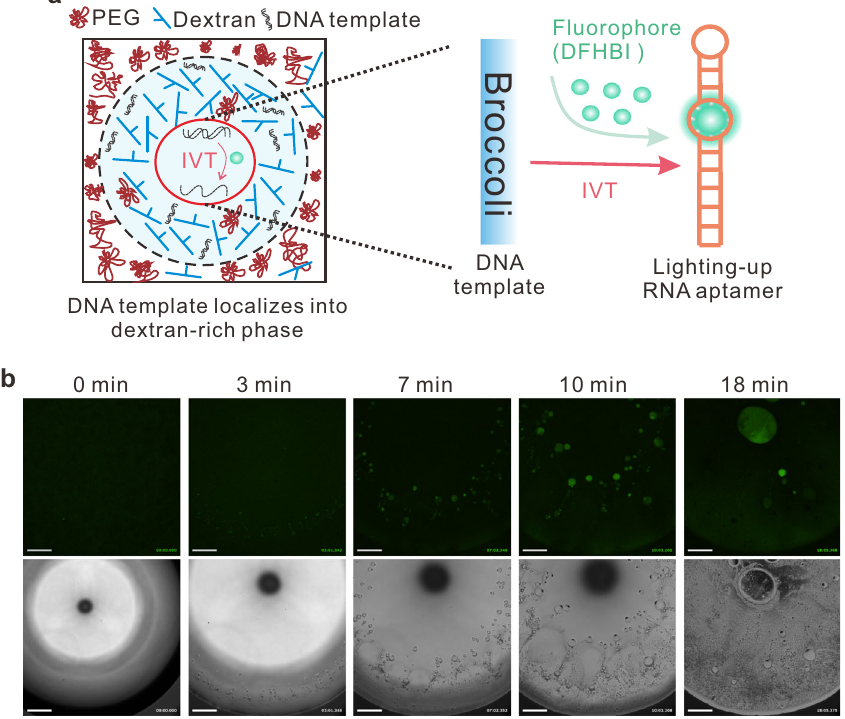
Fig. 4 In vitro transcription of functional RNA aptamers inside the evaporating sessile droplets. a The fl ow of genetic information in phase-separated compartments via in vitro transcription (IVT). The DNA templates are coded for Broccoli aptamer that can bind 5-di fl uoro-4-hydroxybenzylidene imidazolinone (DFHBI) to form a fl uorescent complex of Broccoli – DFHBI. b Optical image sequence shows fl uorescence RNA aptamer transcription from Broccoli DNA template inside the phase-separated compartments. The dextran-rich compartments have increasing green fl uorescence due to the formation of Broccoli-DFHBI complexes. Images are obtained over analysis of three independent trials with relative humidity ranging from 55 to 65%. The scale bar is 500 μ